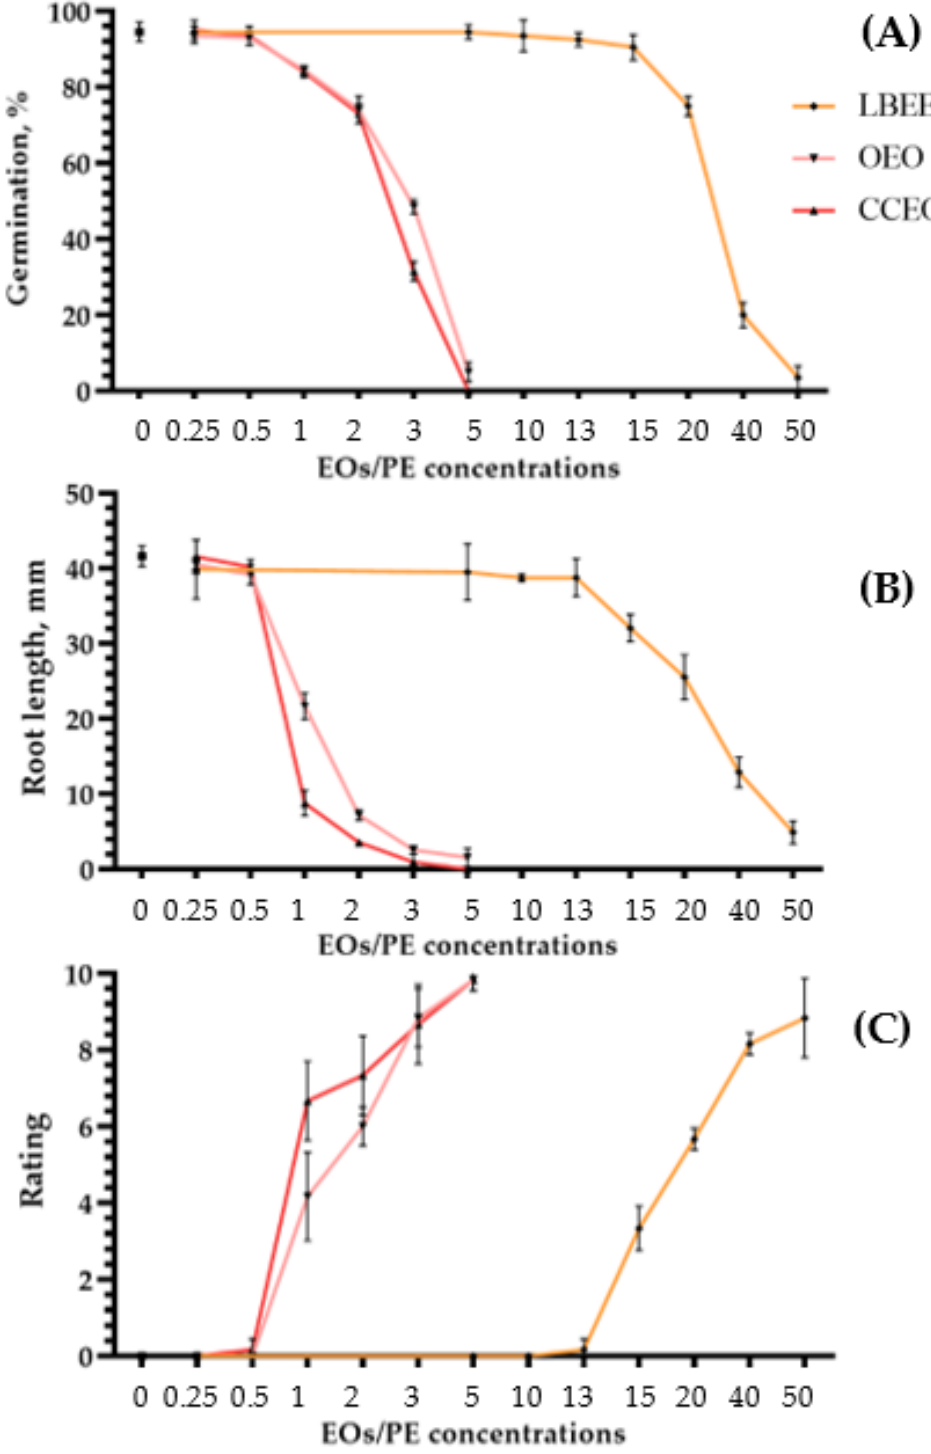
Figure 2. Phytotoxicity of leather bergenia ethanol extract (LBEE), oregano essential oil (OEO) and Chinese cinnamon essential oil (CCEO) on seeds and leaves of soybean. Values of germination ( A ) and root length ( B ) of soybean seeds treated with various concentrations of EOs and LBEE on the 8 DAT. The average score of the integral value of EOs and LBEE phytotoxicity on soybean leaves was 72 h after treatment ( C ). Sterile water was used as a negative control variant. Values in panels represent the respective mean of three independent trials and error bars represent the standard deviation. Values within columns marked by different letters have a significant difference, Duncan’s criteria, p = 0.05.